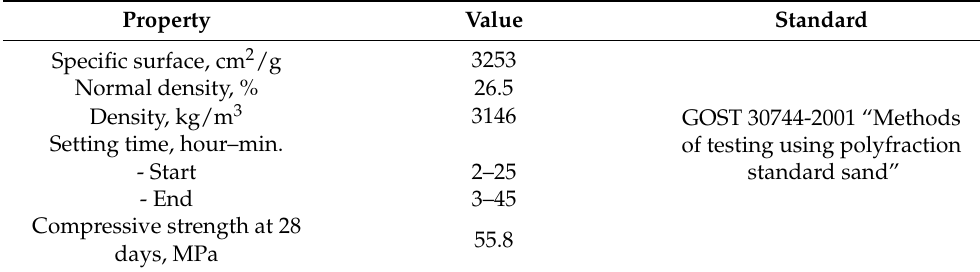
Table 1. Characteristics of